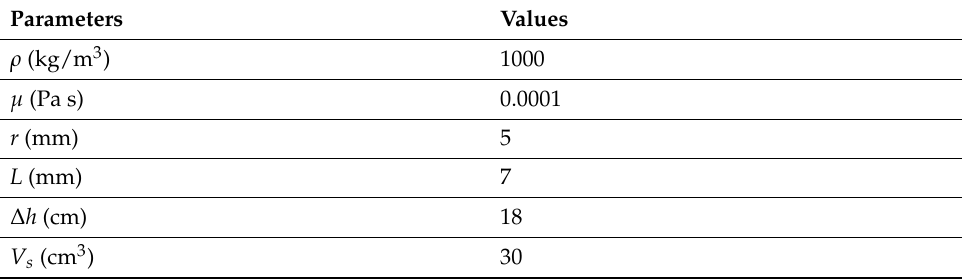
Table 3. Constant parameters used in the model.